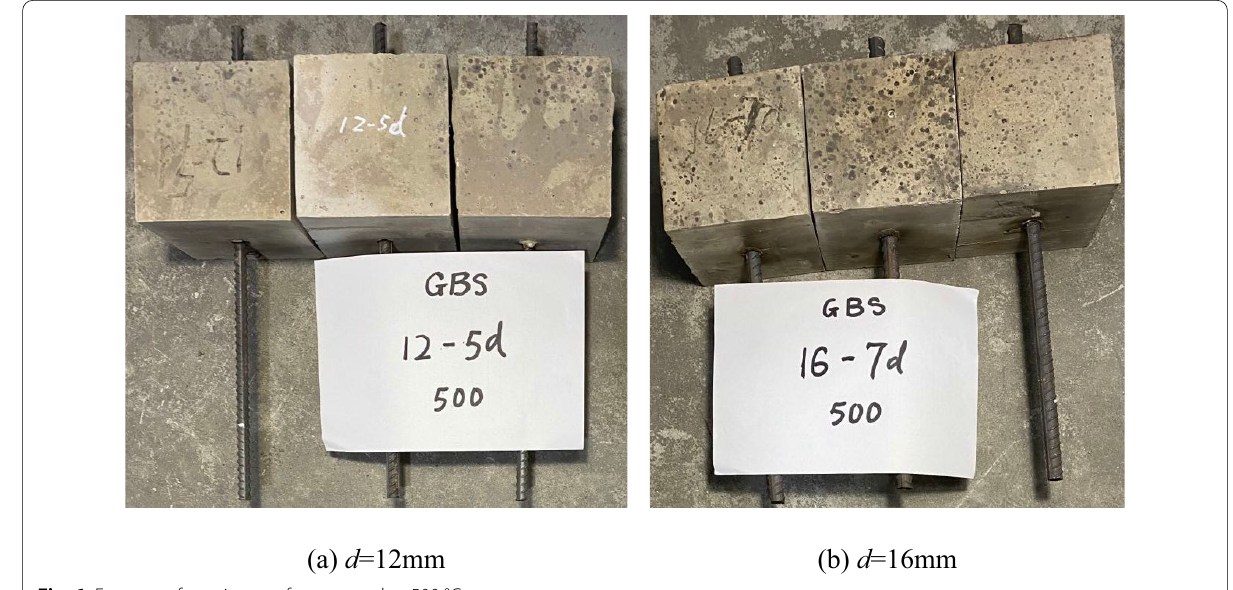
Fig. 6 Features of specimens after exposed to 500